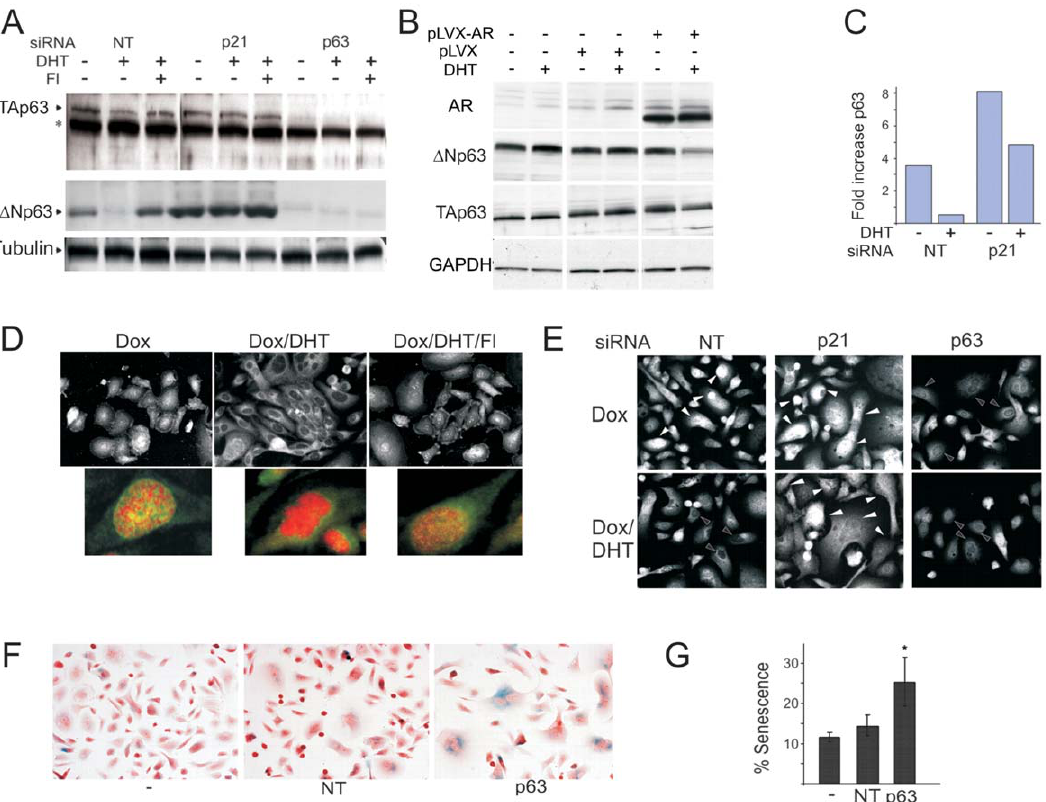
Figure 5. p63 expression is blocked by P21 and contributes to AR-dependent senescence. This figure illustrates the link between p21 and p63 n AR-driven senescence. ( A ) PC3-AR cells were transfected with non-target (NT), p21 or p63 siRNA. Dox 6 DHT were added to the media 24 hours post-transfection. Whole cell lysates were collected after 3 days and p63 expression measured by Western blot. Arrows point to TAp63- a and D Np63; * indicates non-specific band. Note the lack of p63 downregulation in p21 knock-down cells. ( B ) RWPE-1 cells were transfected with pLVX-AR or control pLVX and treated with vehicle EtOH or DHT. TAp63- a and D Np63 were measured as in (A). ( C ) PC3-AR cells were transfected with p21 or non-target (NT) siRNA. The cells were placed in Dox, 6 DHT. RNA was isolated 3 days post-transfection. P63 message was measured by real- time RT-PCR. Note an approximately seven-fold reduction upon DHT treatment and increased expression after p21 knock-down. ( D ) In situ immunofluorescence of PC3-AR cells with pan-p63 antibody. Note pronounced p63 nuclear staining in Dox-treated cells, the lack of nuclear staining after 3 days in DHT and restored nuclear staining in the presence of Fl (top). Below: P63 nuclear localization (green pseudocolor), nuclei are counterstained with DAPI (red pseudocolor); colocalization appears in yellow. ( E ) PC3-AR cells were transfected with p21, p63 or control siRNA, cultured 48 hours in Dox 6 DHT and stained with p63 antibodies. Note similar, diffuse p63 localization with the nuclear presence (filled arrows) in Dox-treated cells, the lack of nuclear localization in the presence of DHT (empty arrows), which is lost after p21 knock-down (filled arrows). P63 knock- down results in a weak, residual cytoplasmic staining. ( F, G ) Parental PC3 cells lacking AR expression were transfected with NT and p63 siRNA, cultured 5 days and senescence measured by SA- b Gal assay. Representative images (left) and quantitative analysis (right) are shown. * indicates P , 0.05.